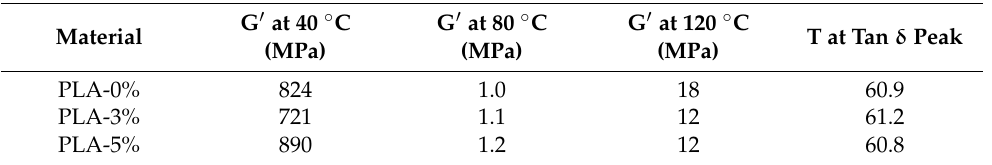
Table 5. Storage modulus before glass transition and crystallization of PLA, PLA-3%, and PLA-5% CaCO 3 fillers, and temperature at Tan δ peak.